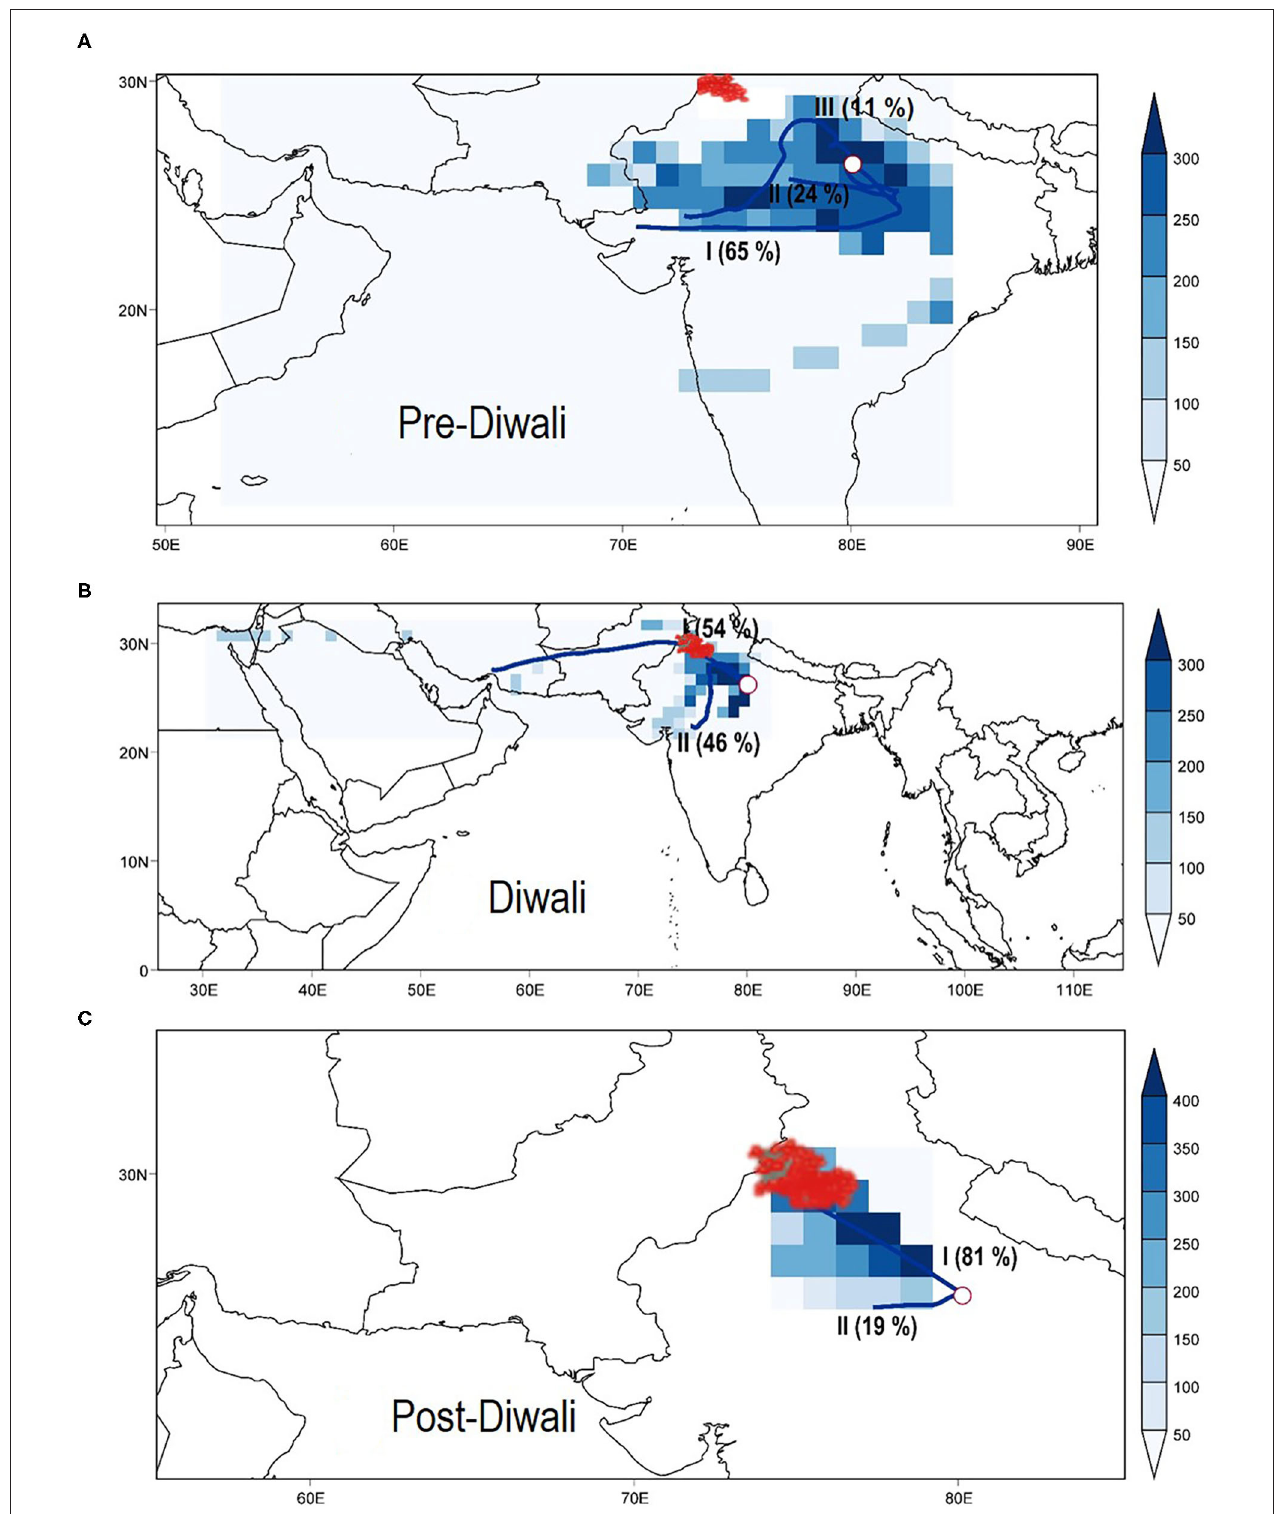
FIGURE 3 | Air-mass cluster analysis and fire-count imageries (shown by red-circles, over source region of biomass burning) during (A) pre-Diwali, (B) Diwali, and (C) post-Diwali periods.